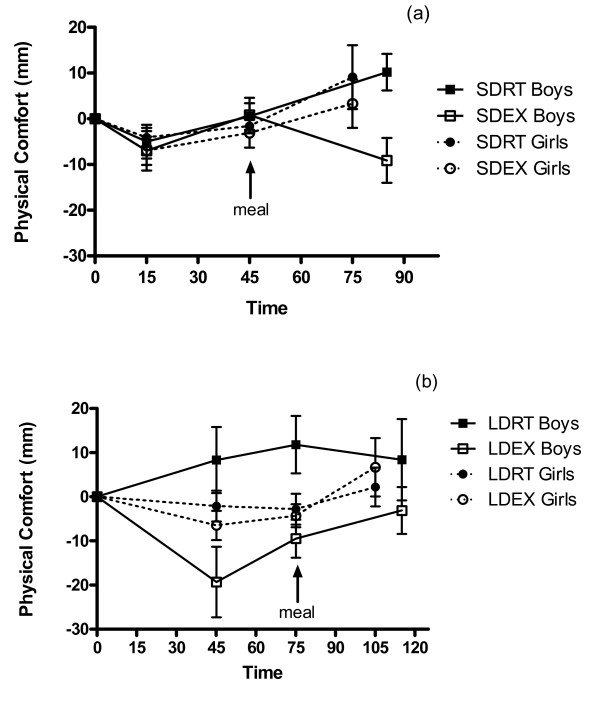
Physical comfort during (a) short- and (b) long-duration sessions in boys and girls. 1SDRT = short-duration rest, SDEX = short-duration exercise, LDRT = long-duration rest, LDEX = long-duration exercise. 2 Change from baseline physical comfort increased over time during SD (a) (p = 0.036), but not LD (b) (p = 0.26) sessions. Neither treatment (p = 0.49), nor sex (p = 0.58) was a factor affecting physical comfort during SD sessions. Physical comfort during LD sessions was affected by treatment (p < 0.0001), but not sex (p = 0.73), and there was a significant treatment × sex interaction (p = 0.0007). 3Test meals began at 45 min (a) and 75 min (b).